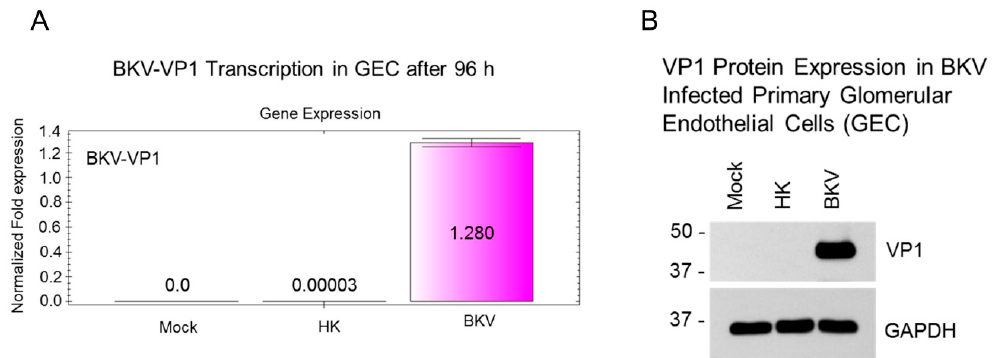
Figure 6. VP1 expression in BKV-Infected glomerular endothelial cells. ( A ) qRT-PCR analysis of mock-infected glomerular endothelial cells or cells exposed to heat-killed or wild-type BKV for 96 h. PCR results were normalized to GAPDH. ( B ) Western blot analysis of BKV VP1 protein expressed in glomerular endothelial cells exposed to mock, heat-killed BKV or wild-type BKV for 96 h. Protein size markers are in kilodaltons. GAPDH is used as a loading control.